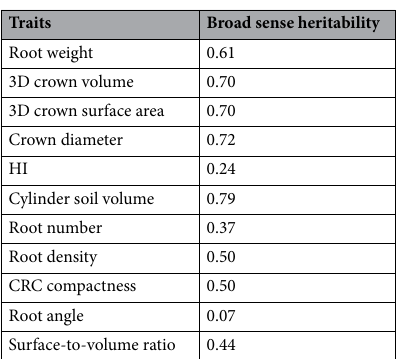
Table 2. Broad sense heritability of nine 3D traits, root weight and